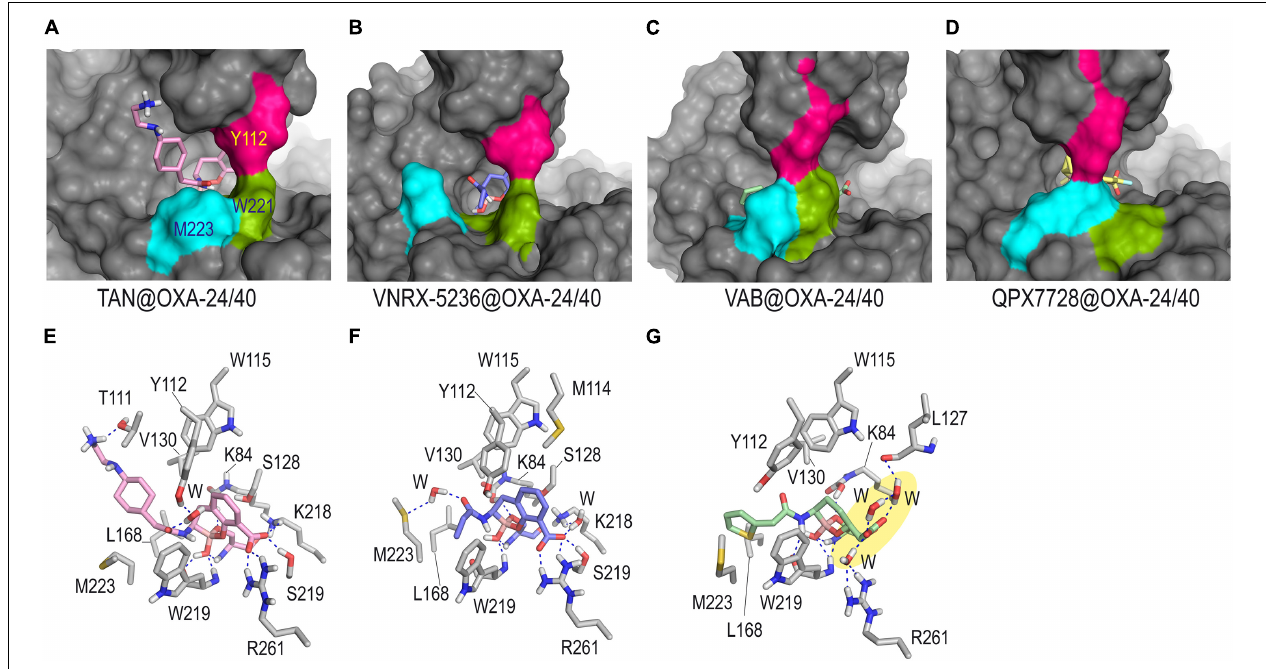
FIGURE 6 | Overall and detailed view of the covalent modification of OXA-24/40 by taniborbactam (A,E) , VNRX-5236 (B,F) , and vaborbactam (C,G) obtained by MD simulation studies. Inactivation of OXA-24/40 by QPX7728 is also shown for comparison in panel (D) . The residues involved in the tunnel-like entrance, Y112 (pink), M223 (cyan), and W221 (green) are highlighted. Snapshots taken after 90 ns (TAN@OXA-24/40, QPX7728@OXA-24/40), and 80 ns (VNRX-5236@OXA-24/40, VAB5236@OXA-24/40) of simulation are shown. Relevant side chain residues are shown and labeled. Hydrogen bonding interactions are shown as blue dashed lines. Note how for TAN@OXA-24/40 and VNRX-5236@OXA-24/40 the extra hydrogen bonding interactions promoted by the amide group would induce significant modifications on the hydrophobic bridge architecture. No direct contacts between the carboxylate group of the modified vaborbactam and the enzyme residues were identified (yellow shadow). TAN, taniborbactam; VAB,